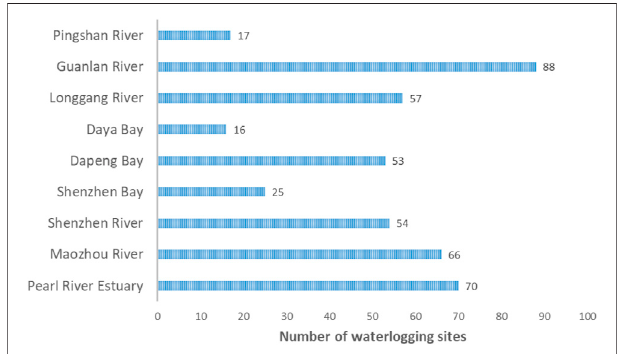
FIGURE 1 | Number of waterlogging sites across various watersheds in